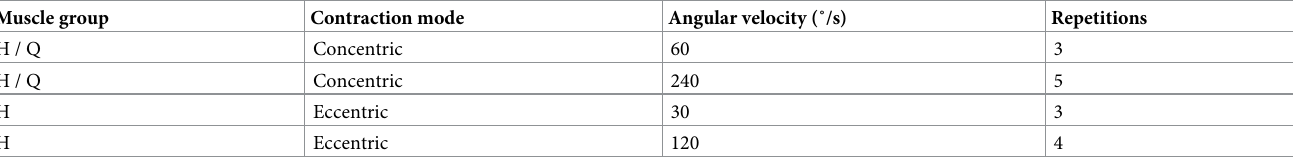
Table 1. Crosier’s isokinetic test protocol. Muscle